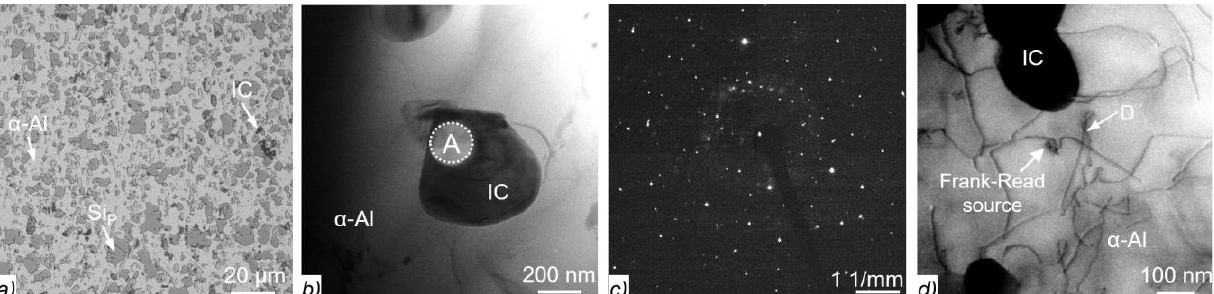
Figure 1. Microstructure of the base material: ( a ) light optical micrograph overview (Al solid solution (α -Al), primary precipitated silicon (Si P ), intermetallic compounds (IC)); ( b ) bf-TEM image of intermetallic phase with SAED analysis area A; ( c ) diffraction pattern from area A; ( d ) bf-TEM image of Al matrix with precipitations IC and dislocations D.